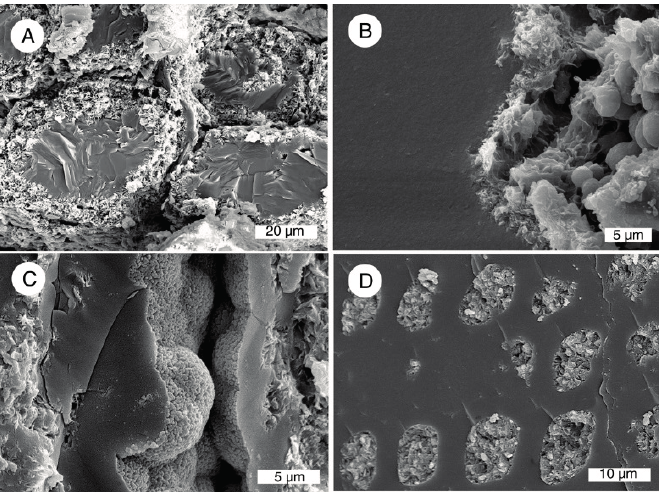
Figure 12. Massive opal. ( A ) Opal-CT, transverse view, cell walls mineralized with porous opal, lumina with massive filling, locality 2 (Rainbow Ridge opal mine); ( B ) Wood mineralized with vitreous opal-CT, microcrsystalline textures visible only in open voids, locality 2 (Toni opal mine); ( C ) Opal-CT, radial view of a tracheid showing massive cell walls, with botryoidal microcrystalline texture visible on surfaces facing partially empty lumen, locality 2 (Rainbow Ridge opal mine); ( D ) Opal-CT, transverse view, massive cell walls, lumina with porous opal filling, locality 2 (Toni opal mine).